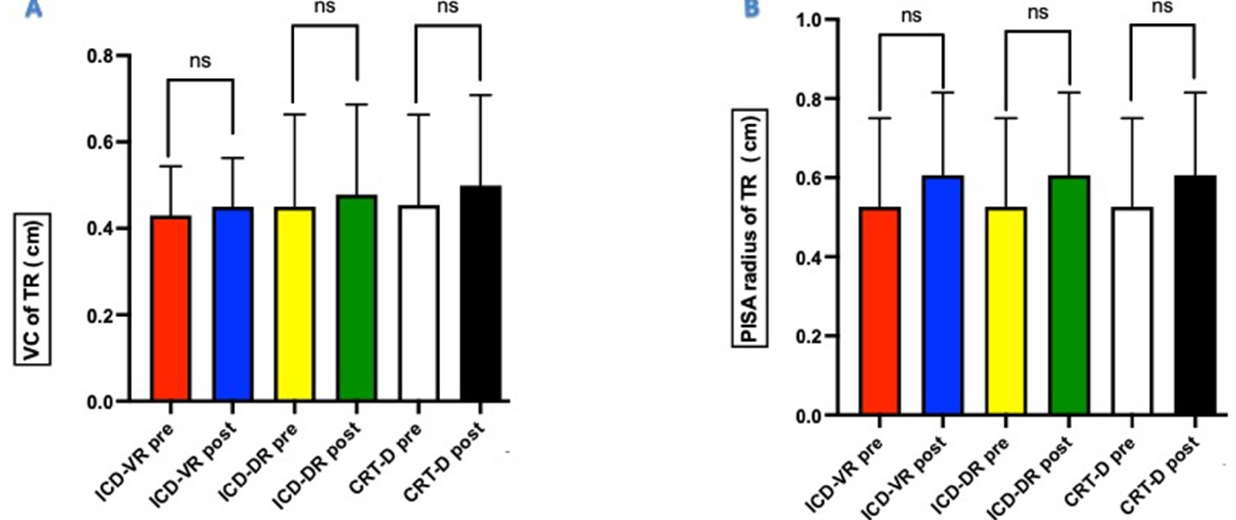
Figure 2. Value of vena contract (panel ( A )) and proximal isosurface area radius (panel ( B )) of tricuspid regurgitation before and after Optimizer ® Smart implantation. ns: non-significance. ICD-VR: single-chamber implantable cardioverter-defibrillator; ICD-DR: dual-chamber implantable cardioverter-defibrillator; CRT-D: cardiac resynchronization therapy with implantable cardioverter-defibrillator back-up.